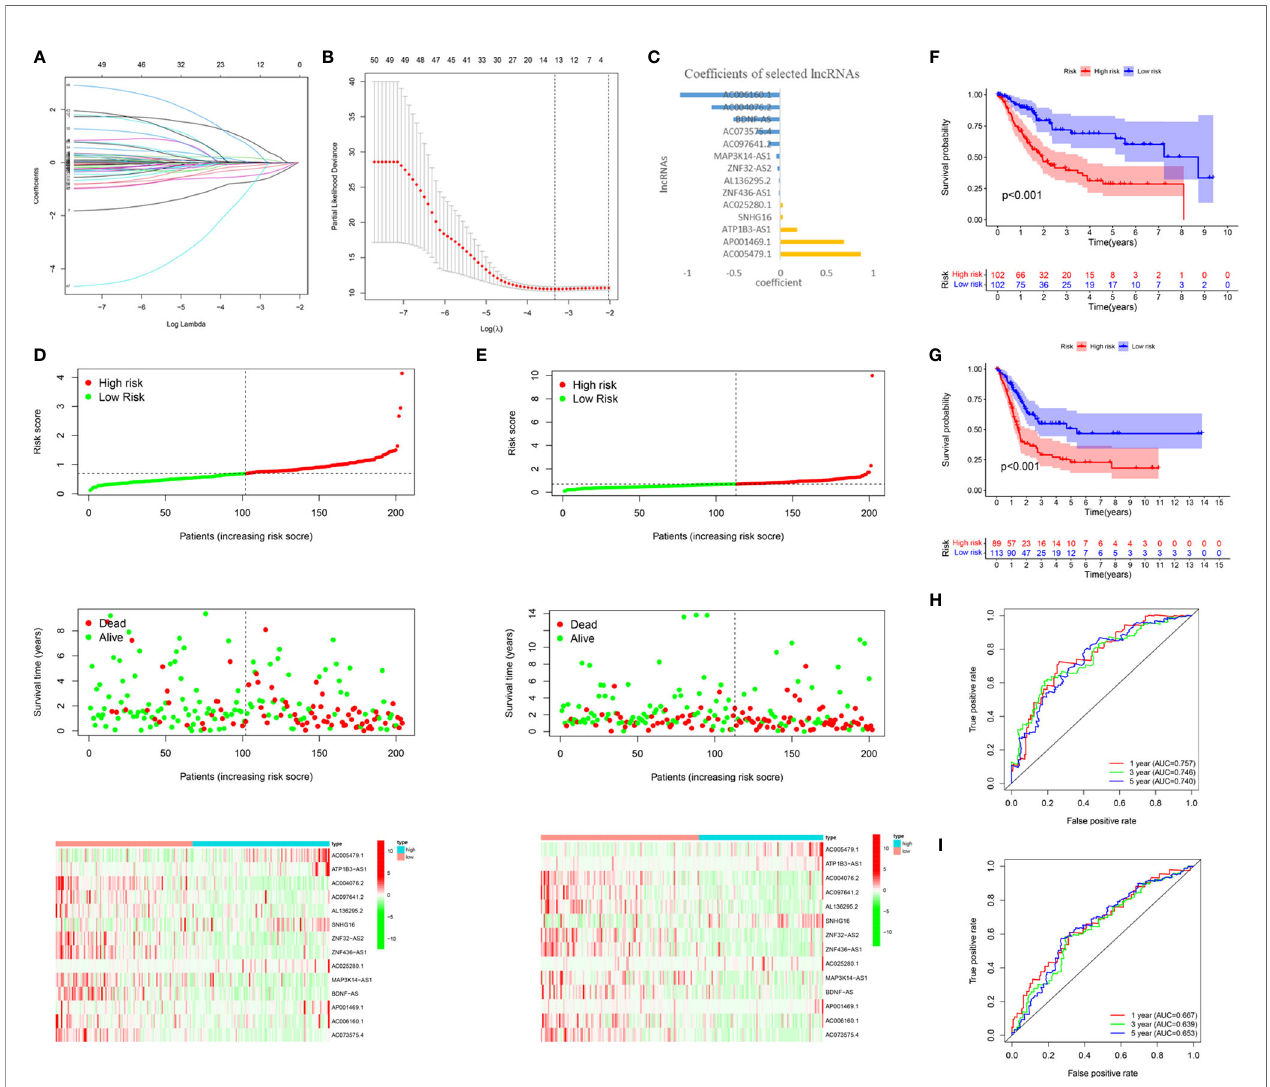
FIGURE 5 | Construction and validation of the m6A-LPS in the TCGA cohort. (A – C) LASSO regression analysis was performed, and the minimum criteria (A, B) and coef fi cients (C) were calculated. (D, E) Distribution of risk scores, OS rates, and OS statuses and the heatmap of the 14 prognostic m6A-related lncRNAs in the TCGA training cohort (D) and the TCGA validation cohort (E) . (F, G) Kaplan-Meier curves of OS rates for bladder cancer patients based on the risk scores in the TCGA training cohort (F) and the TCGA validation cohort (G) . (H, I) Time-dependent ROC curves for the TCGA training cohort (H) and the TCGA validation cohort (I)